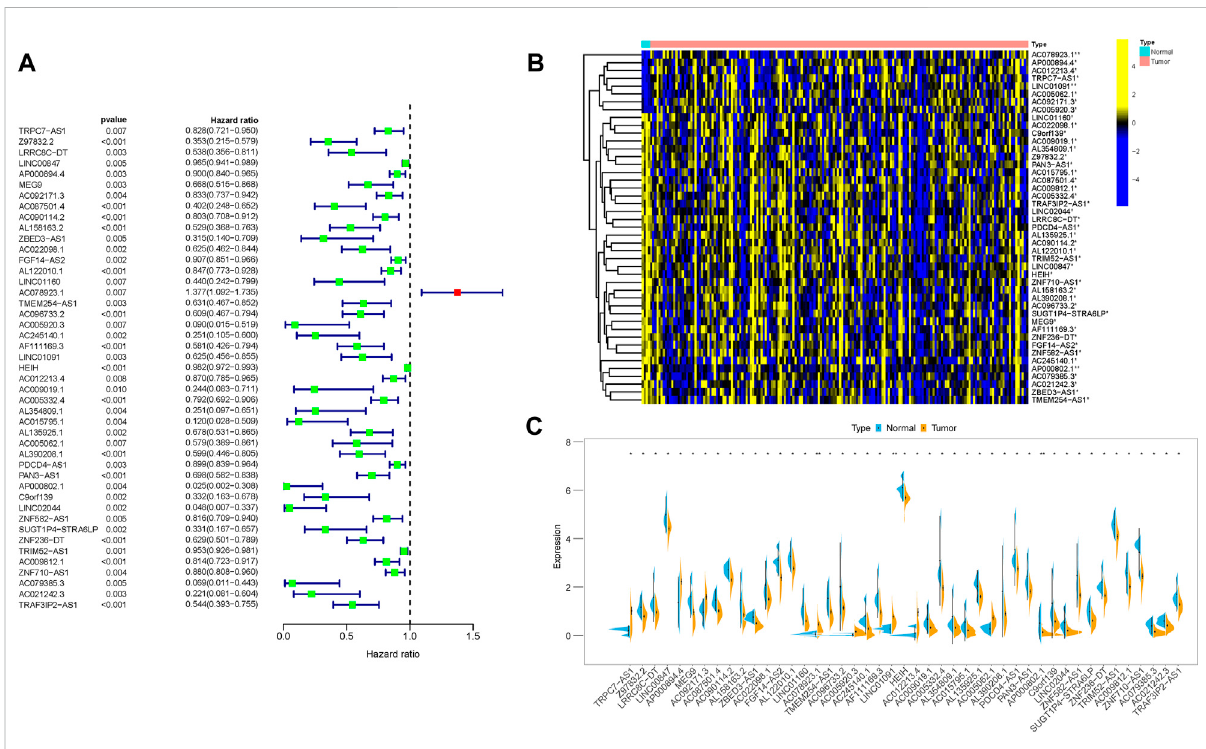
FIGURE 3 Prognosticvalueofm6A-relatedlncRNAsinPDAC. (A) Forestplotofprognosticm6A-relatedlncRNAsunderunivariableregressionanalysis. (B) Heatmap of m6A-related lncRNA expression levels in normal and tumor samples. (C) Differentially expression analysis of m6A-related lncRNAs in normal and tumor samples. * p < 0.05; ** p < 0.01; *** p <